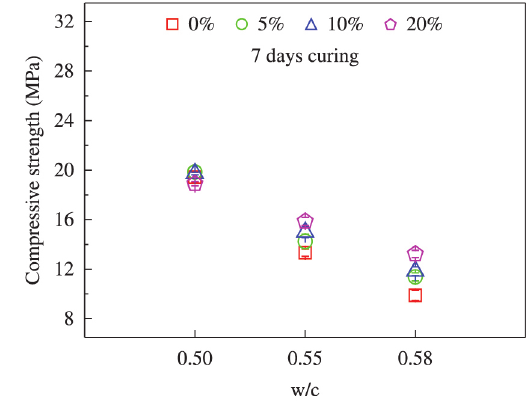
Figure 4. Compressive strength as a function of the w/c ratio after 7 days of curing.